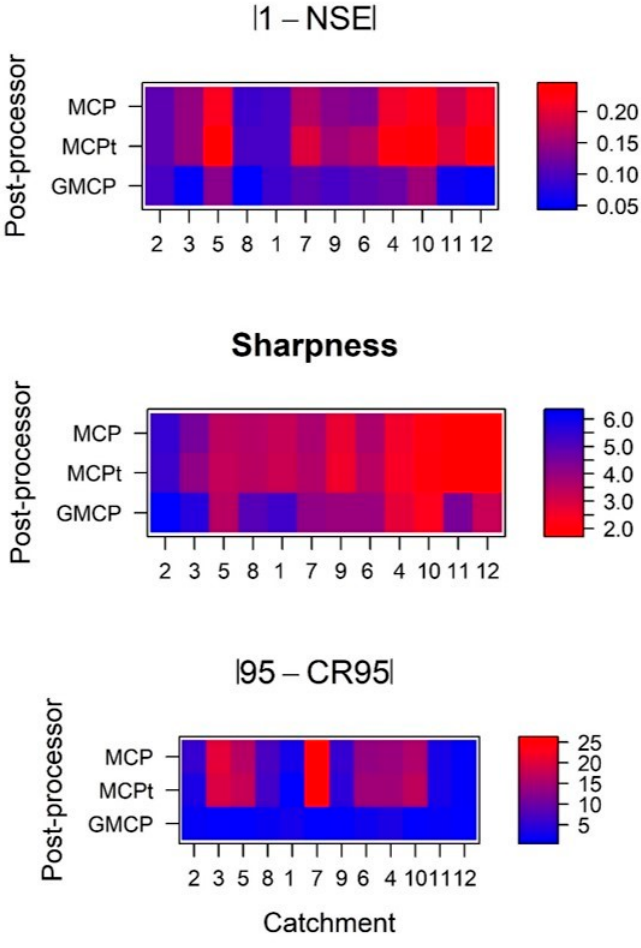
Figure 7. Comparison of the deterministic and probabilistic metrics computed for the three post- processors during the validation period (1980–1998) for 12 MOPEX catchments. MCP (model condi- tional processor), MCPt (MCP using the truncated Normal) and GMCP (Gaussian mixture clustering